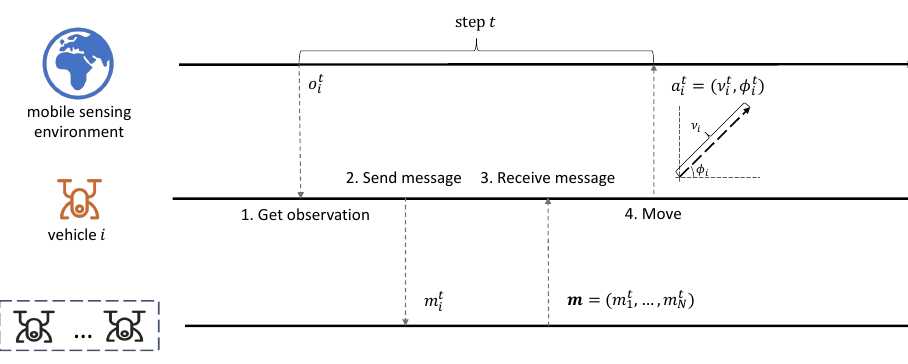
Figure 2. An illustration of the procedure. With local observation, the vehicles first exchange their messages by broadcasting. Afterwards, they make the moving decision based on the received message and local observation. This figure shows the communication process of the ego vehicle i in a single step t : The vehicle first obtains the observation o t in the environment. The vehicle then broadcasts i ) from other a message m t to other vehicles based on the observation. The messages ( m t , . . . , m t N i 1 vehicles will also be aggregated as part of the observation. Vehicle i will finally make the moving decision a t based on the environment observation and the aggregated i